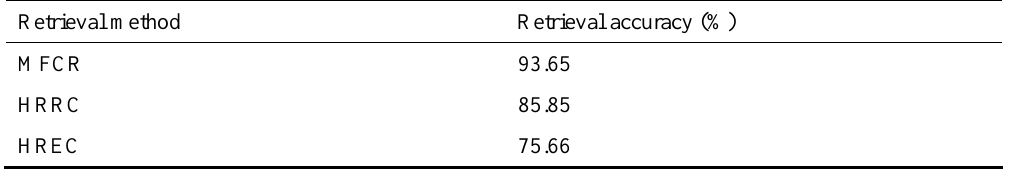
Table 2: Retrieval accuracy(%) of MFCR, HRRC, and HREC retrieval methods. Results are reported for each method using 1–NN